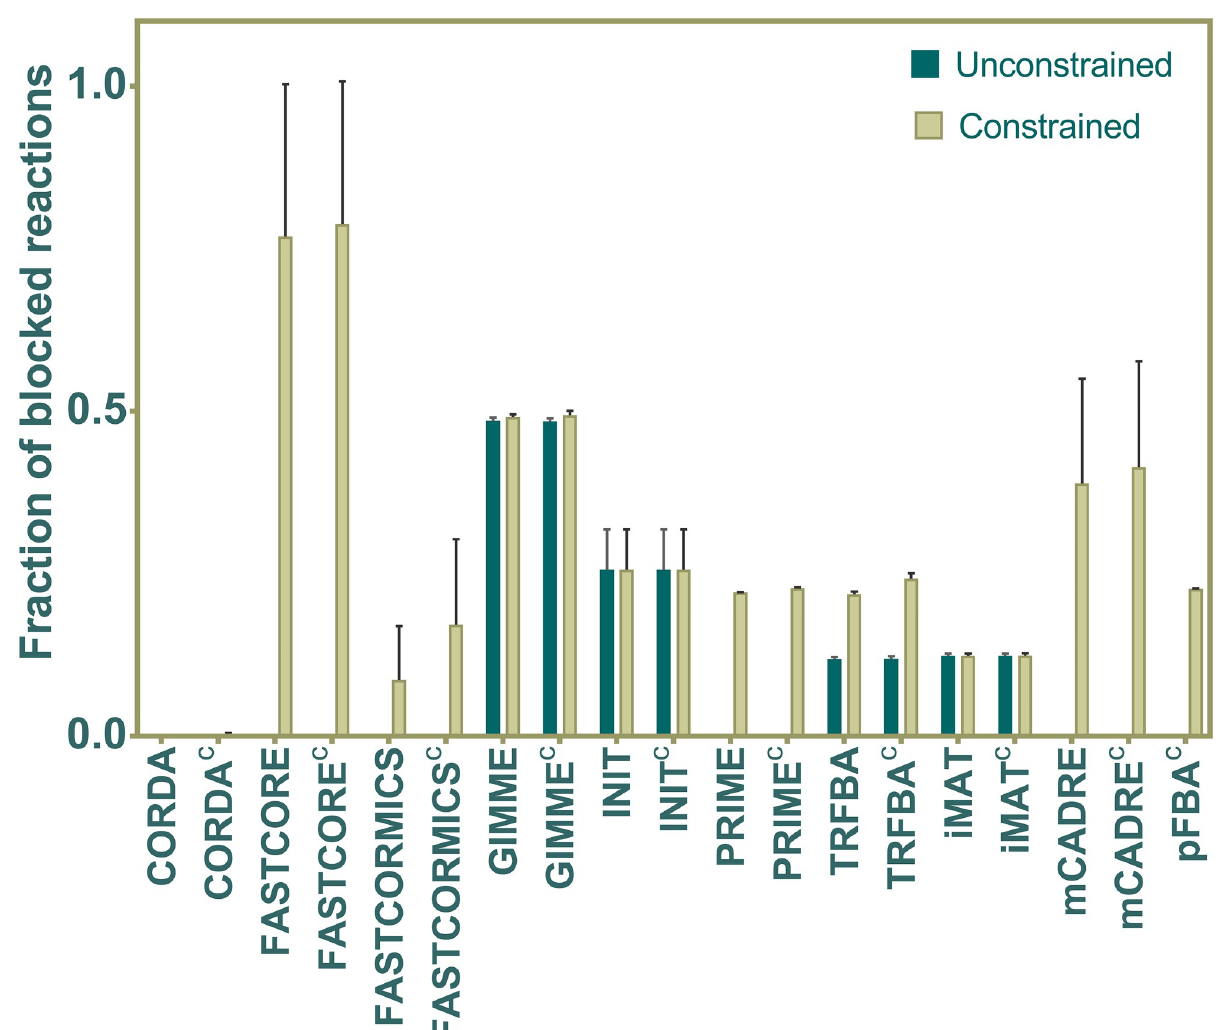
Fig 6. Network connectivity of generated GEMs. The fast consistency evaluation method [16] was used to identify the fraction of blocked reactions in the GEMs reconstructed by each method. The presence of blocked reactions were assessed in both constrained and unconstrained states. Data shown as mean fraction of existing blocked reaction across all generated GEMs, and error bars represent the standard